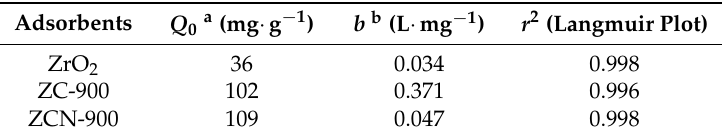
Table 3. Maximum adsorption capacities and Langmuir parameters for the adsorption of SA on different